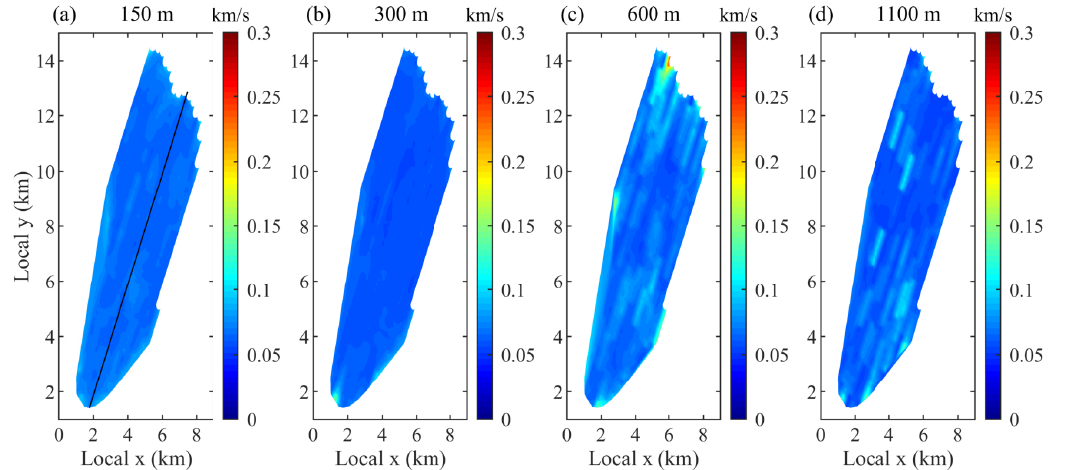
Figure 13. ( a – d ) show horizontal slices of the standard deviation of the shear-wave subsurface structure at the depth of 150, 300, 600 and 1100 m, respectively. The black line in ( a ) shows the location of Figure